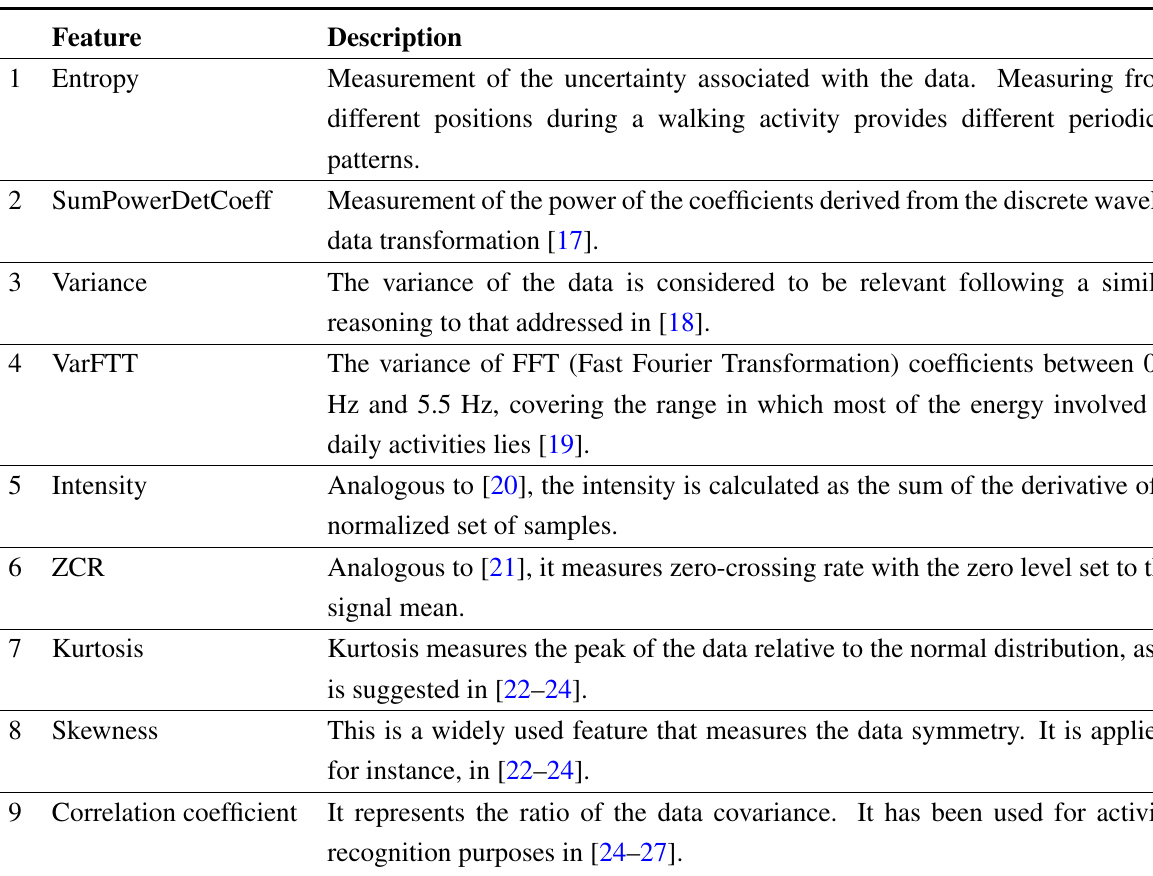
Table 1. Summary of the features extracted from magnetic field